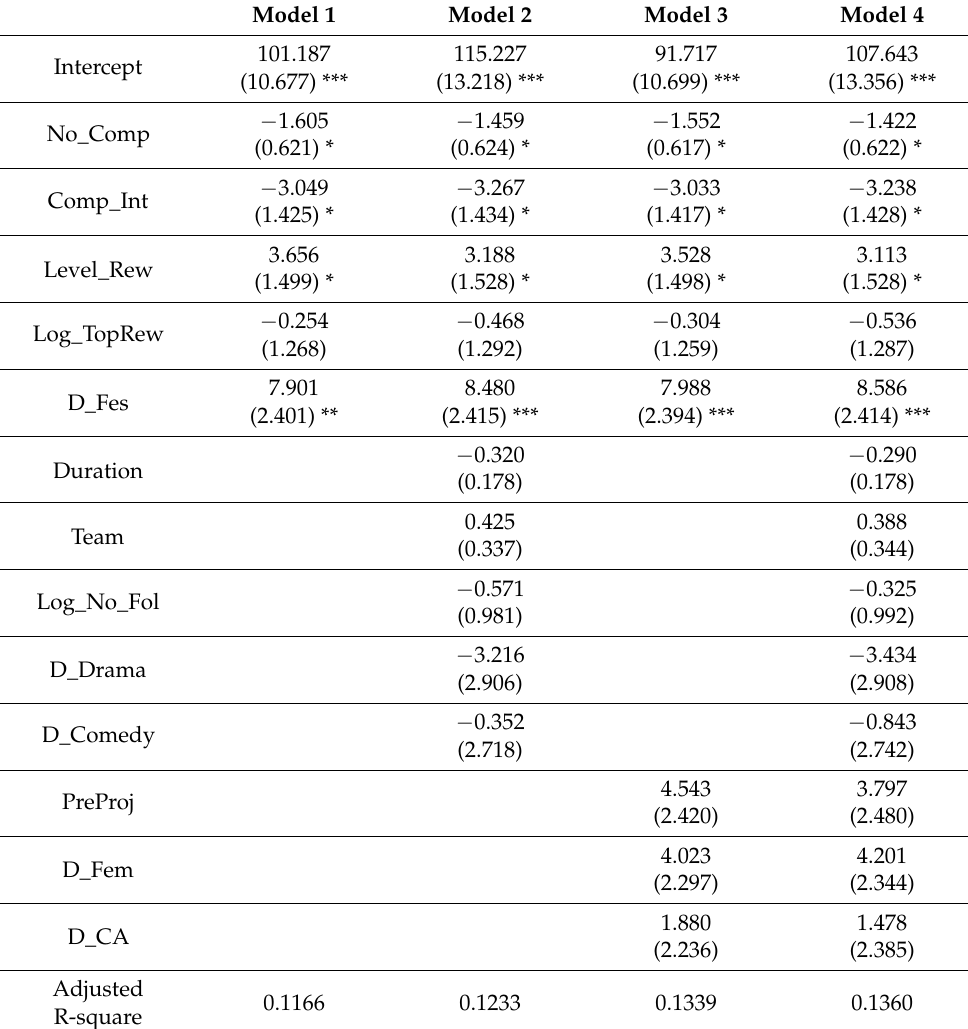
Table 3. Summary of regression analysis (Standard errors in the parentheses) N =